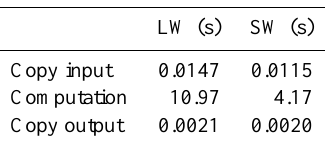
Table 4. Comparison of the computation time versus the time needed to transfer the data to/from main memory and the SPE’s local storage.